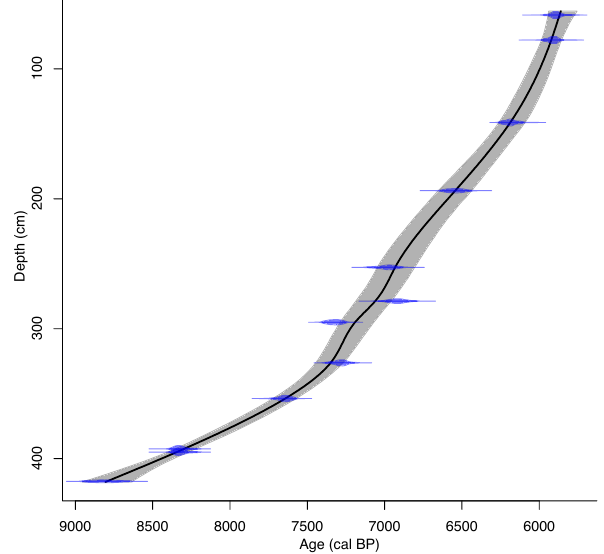
Figure 3. Age–depth relationship of the early to mid-Holocene sec- tion of core SL163 (55–400cm). Blue areas indicate the conven- tional 14 C-calibrated ages; the black line indicates the interpolation between the dated samples using a smooth spline fit and the 95% confidence level (grey